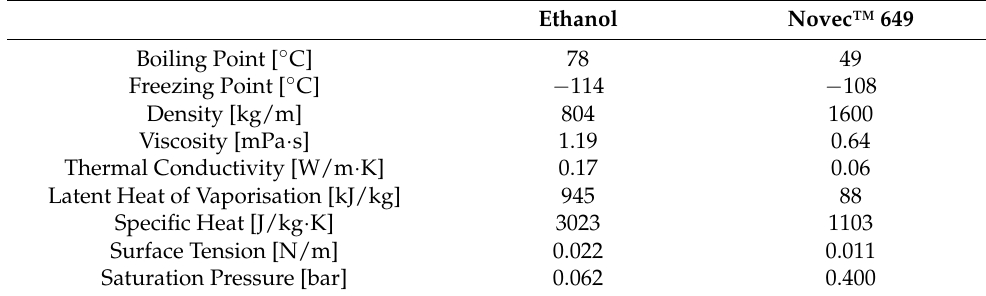
Table 6. Key physical properties of ethanol and Novec™ 649. All properties are evaluated at 20 ◦ C.